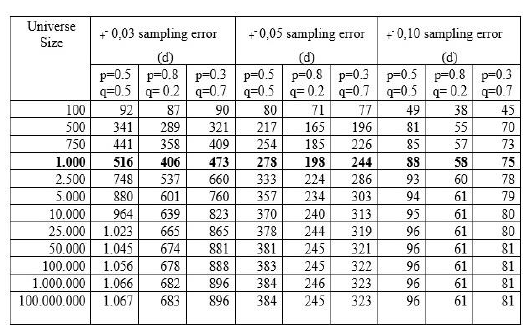
Table 6: Sample Sizes for  = 0.05